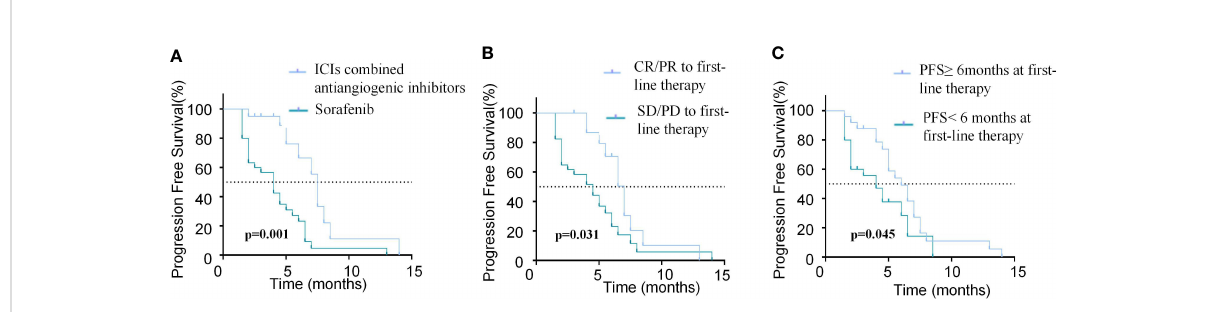
FIGURE 4 Comparison of PFS in patients with different modalities and ef fi cacy of fi rst-line treatment. (A) Kaplan-Meier curves of PFS between patients with ICIs combined antiangiogenic inhibitors or sora fi nib for the fi rst-line treatment. (B) Kaplan-Meier curves of PFS between patients who achieved CR/PR or SD/PD in the fi rst-line treatment. (C) Kaplan-Meier curves of PFS between patients with PFS ≥ 6months or PFS<6months in the fi rst-line treatment.